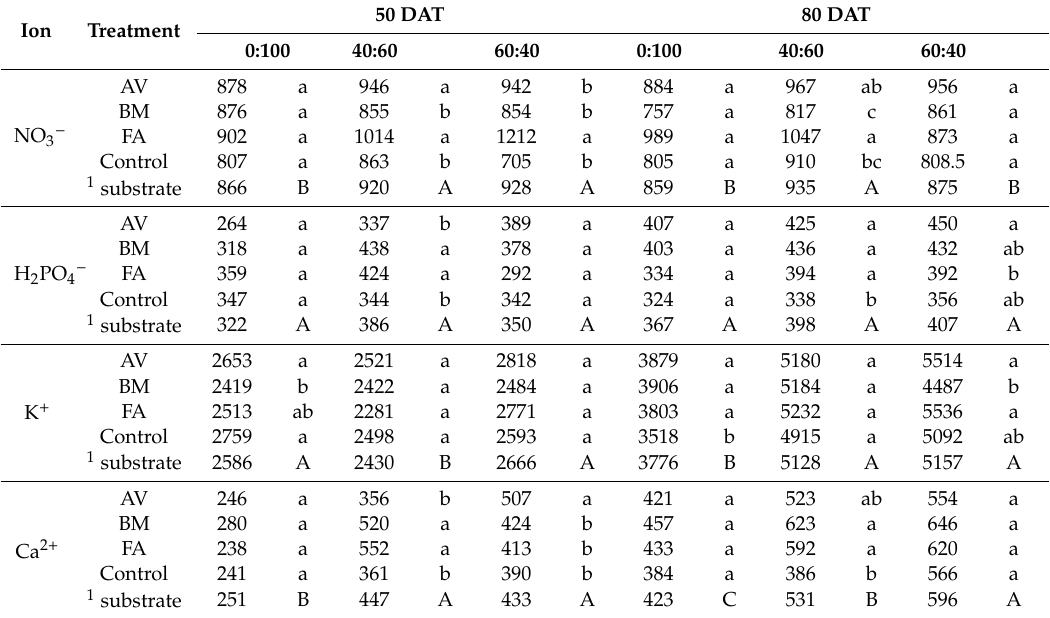
Table 9. Petiole cellular extract analysis for the melon crop (mg L − 1 .). DAT, days after transplant.